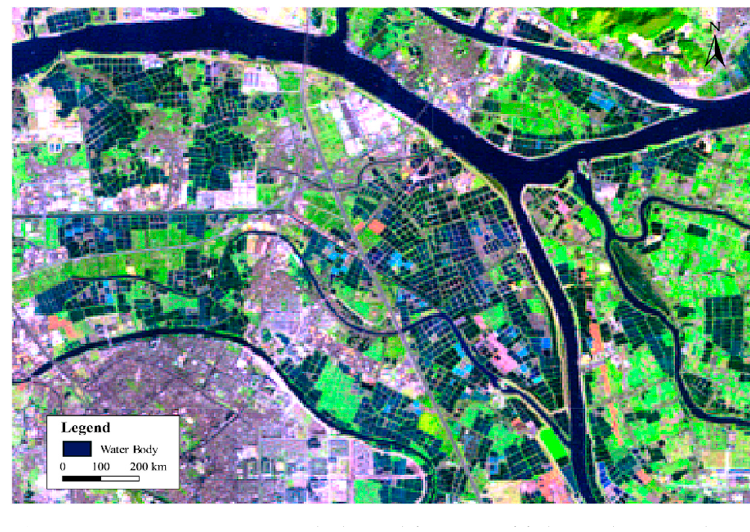
Figure 6. Representative morphological features of fish ponds in Landsat images.